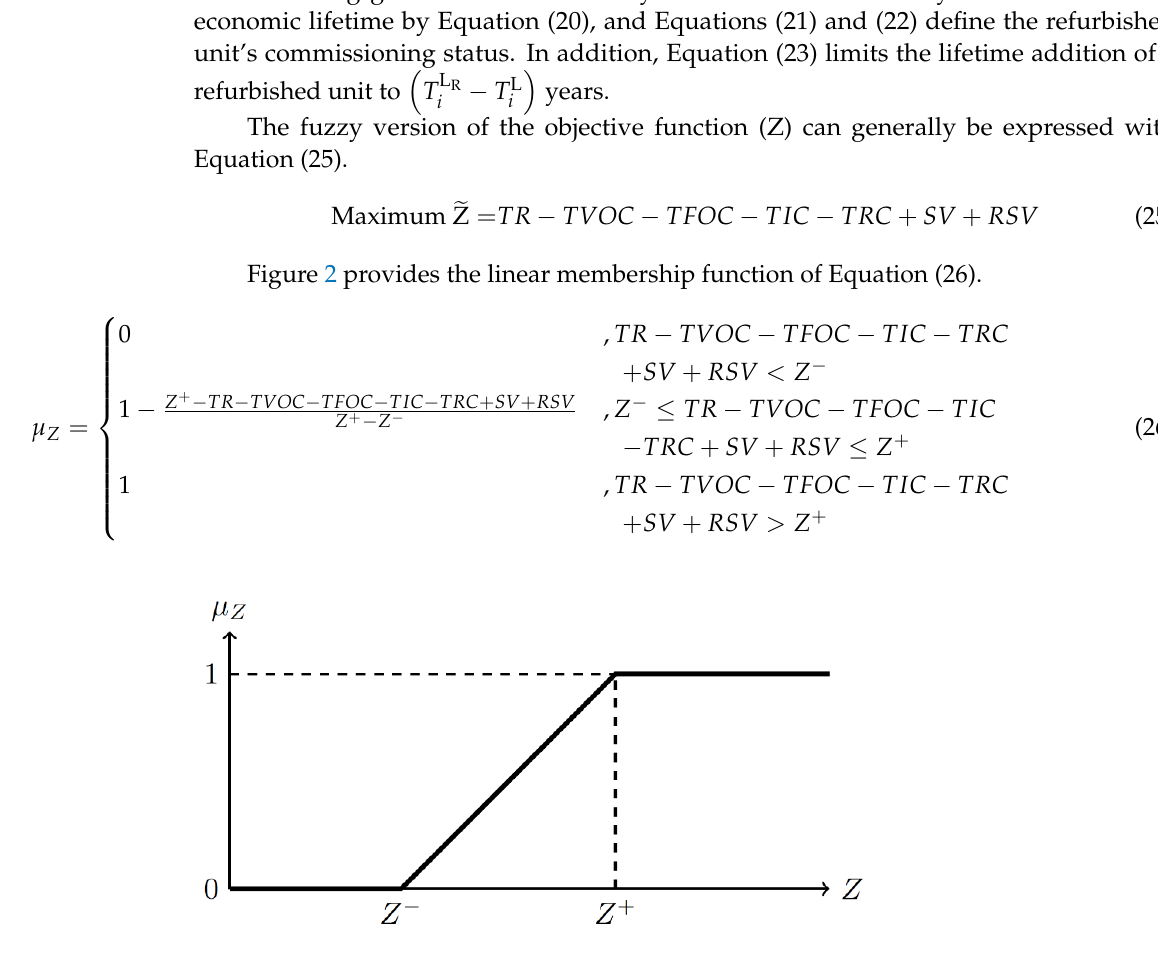
Figure 2. Fuzzy membership function for the objective function.